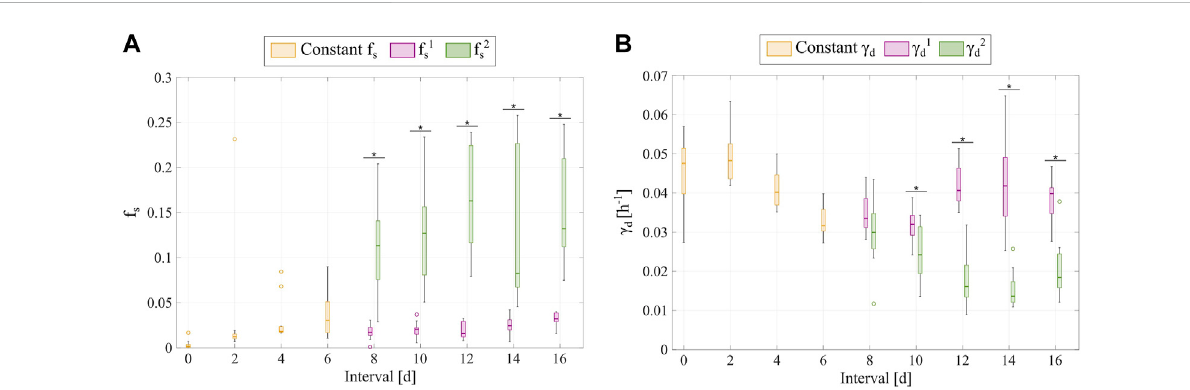
FIGURE 7 Comparison of the f s and γ d distributions obtained from fi tting the multiple-dose model to the experimental data for varying inter-treatment intervals. The parameter distributions are represented as boxplots and were obtained from fi tting the multiple-dose model to the varying inter- treatment interval datasets from Experiment 2 (Table 1). Outliers are represented with circles. Panel (A) shows the distributions for the fraction of surviving cells ( f s ). Panel (B) shows the distributions for the doxorubicin-induced death delay rate of the irreversibly damaged tumor cells ( γ d ). For 0 – 6 days inter-treatment intervals, f s and γ d are kept constant in the model (yellow boxplots); whereas, for 8 – 16 days inter-treatment intervals, we vary f s and γ d with each doxorubicin dose ( f 1 s , γ 1 d : purple boxplots, f 2 s , γ 2 d : green boxplots). As the inter-treatment interval is lengthened from 0 to 6 days, the constant f s and γ d show a trend towards higher surviving fractions and slower transitions to doxorubicin-induced death, suggesting increasingly poorer tumor control. When f s and γ d are varied with each dose, we observe that thesecond f s values correspond to signi fi cantly higher surviving fractions for 8-, 10-, 12-, 14-, and 16- day inter-treatment intervals (p : 4 . 7 × 10 − 5 , 3 . 7 × 10 − 5 , 3 . 7 × 10 − 5 , 3 . 7 × 10 − 5 , and 3 . 7 × 10 − 5 , respectively) and that the second γ d values represent signi fi cantly slower transitions to treatment-induced death for 10-, 12-, 14-, and 16- day inter- treatment intervals (p : 0 . 0141, 3 . 7 × 10 − 5 , 6 . 0 × 10 − 5 , and 9 . 7 × 10 − 5 , respectively). These changes in f s and γ d after the second dose also suggest an increasingly poorer tumor control after the second dose with a longer inter-treatment interval. An asterisk (*) indicates p < 0.05 in two-sided Wilcoxon rank sum tests comparing the distributions of the two f s and γ d values obtained for each inter-treatment interval where the multiple-dose model with varying parameters was